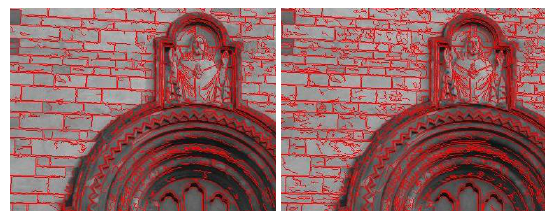
Figure 2. Extracted edges using different Canny’s thresholds.